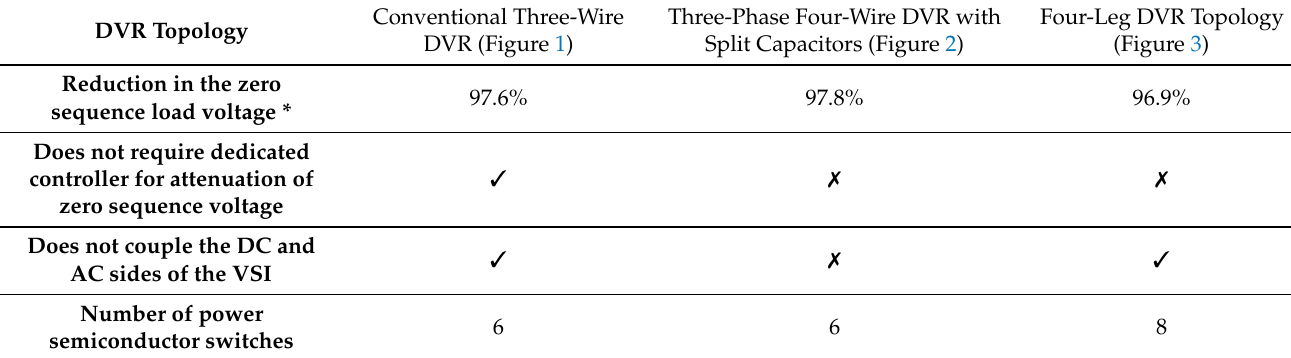
Table 3. Summary of the comparative study of the DVR topologies discussed in this paper (simulation results). DVR